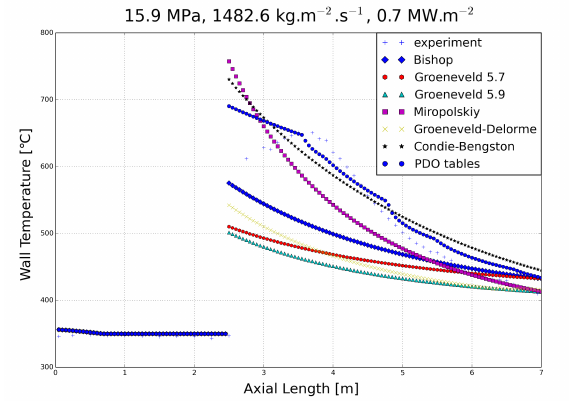
Figure 2. Dependence of calculated and experimental wall temperature on axial length.